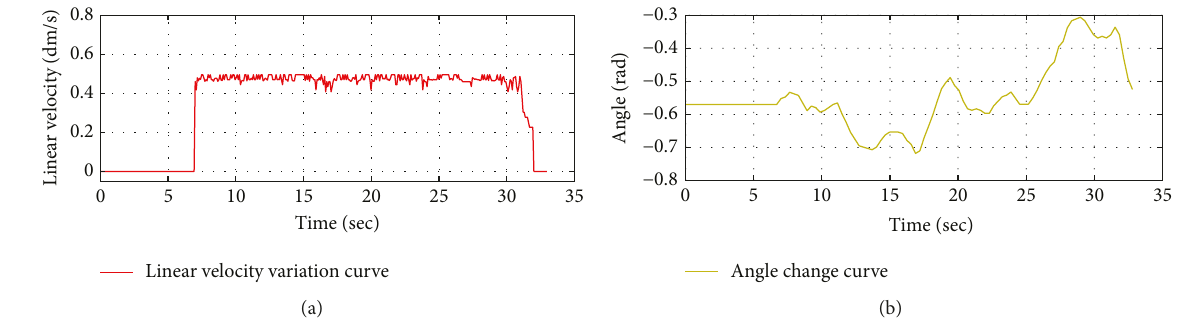
Figure 24: Parameter output results. (a) Linear velocities. (b) Attitude